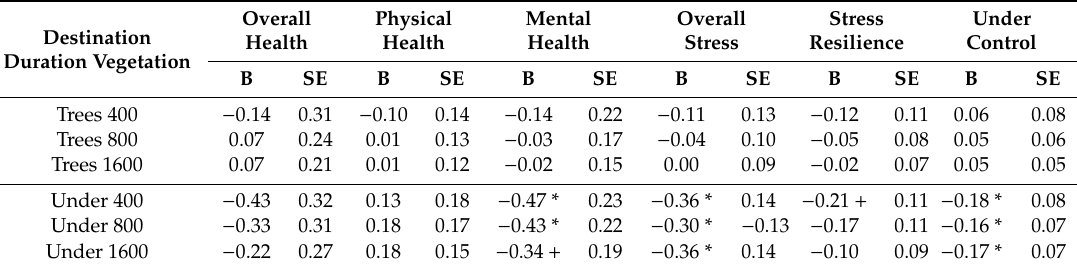
Table 5. Relationship between Nature Exposure around Destinations and Health